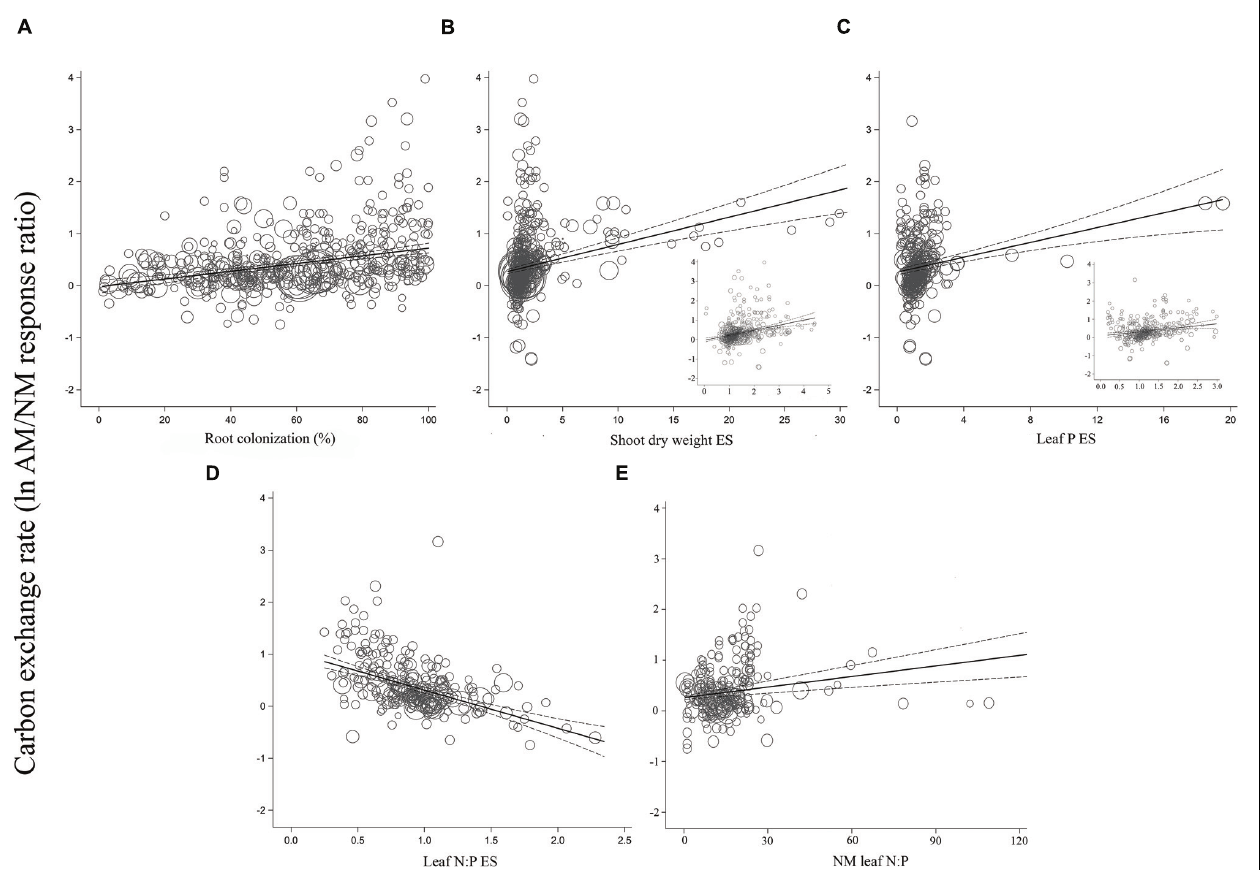
FIGURE 3 | Regression plots of the size of the AM-induced change in carbon exchange rate (ln R CER) as a function of (A) percent root colonization; (B) AM/NM shoot DW effect size; (C) AM/NM leaf P effect size; (D) AM/NM leaf N:P effect size; (E) leaf N:P of NM plants. Darker center line is the model prediction; lighter lines are 95% confidence intervals. Each symbol represents one study, with symbol size indicating its weighting. Insets in (B) and (C) are expanded views of the ranges containing the majority of studies.